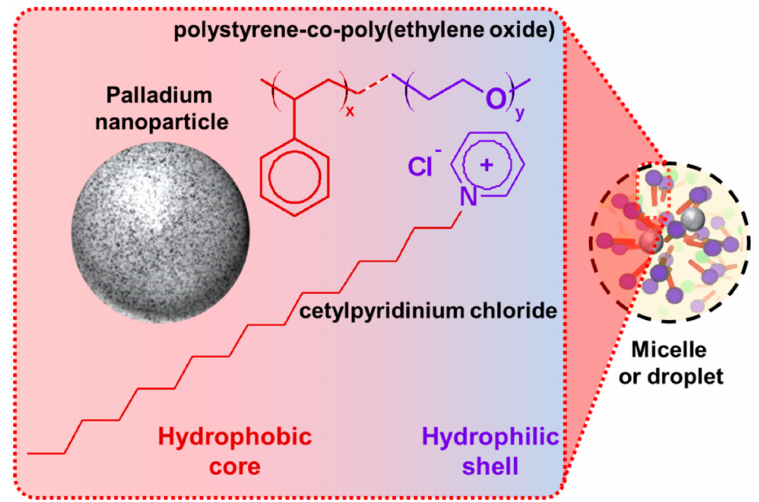
Figure 26. A palladium colloidal system stabilized by a block copolymer and a cationic surfactant.